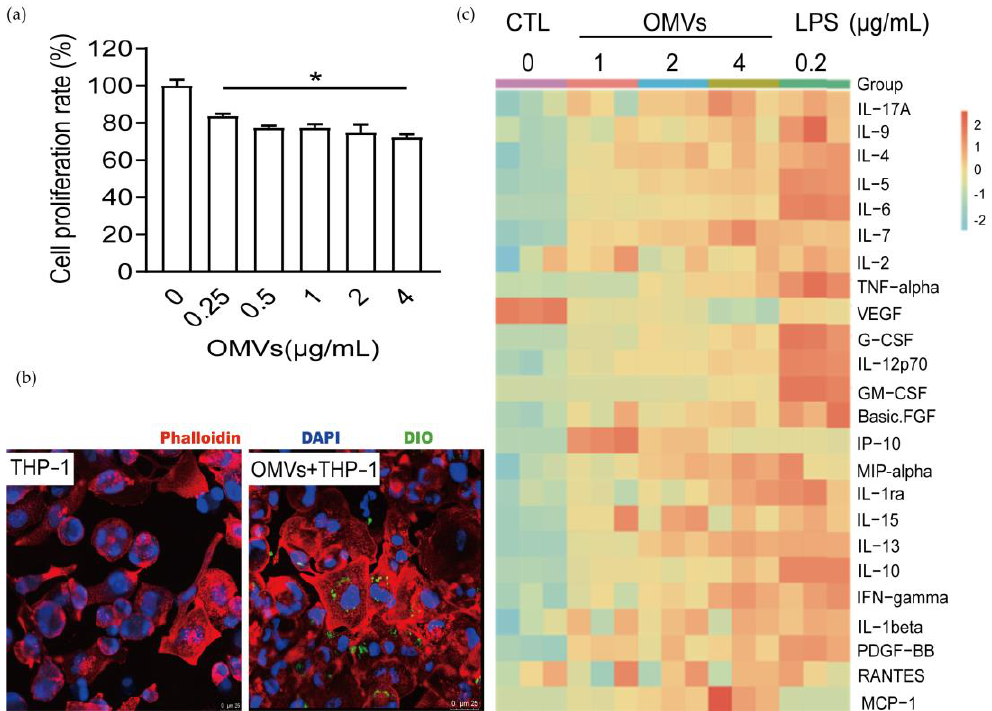
Figure 5. The effects of D. fairfieldensis OMVs on THP-1- Mφ cell. ( a ) Effects of OMVs on the viability of THP-1- Mφ cells. * p < 0.05 by Student’s t test. ( b ) The result of confocal laser tracing OMVs taken by THP-1- Mφ cells. Scale bar: 25 μm. The red fluorescent dye of phalloidin was used to label the cytoskeleton protein of THP-1 derived macrophages, the blue fluorescent dye of DAPI was used to label the nuclei, and the green fluorescent dye of DIO was used to label the lipid structure of OMVs. ( c ) Secretion of inflammatory factors by THP-1- Mφ cells stimulated by OMVs from D. fairfieldensis .